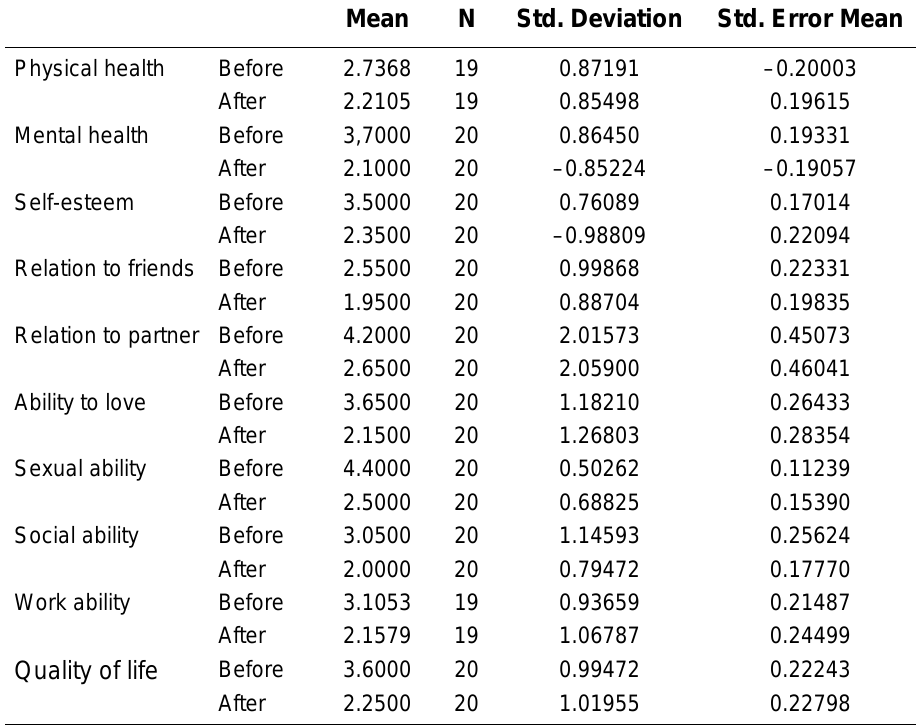
Patients with Sexual Problems who Succeeded in